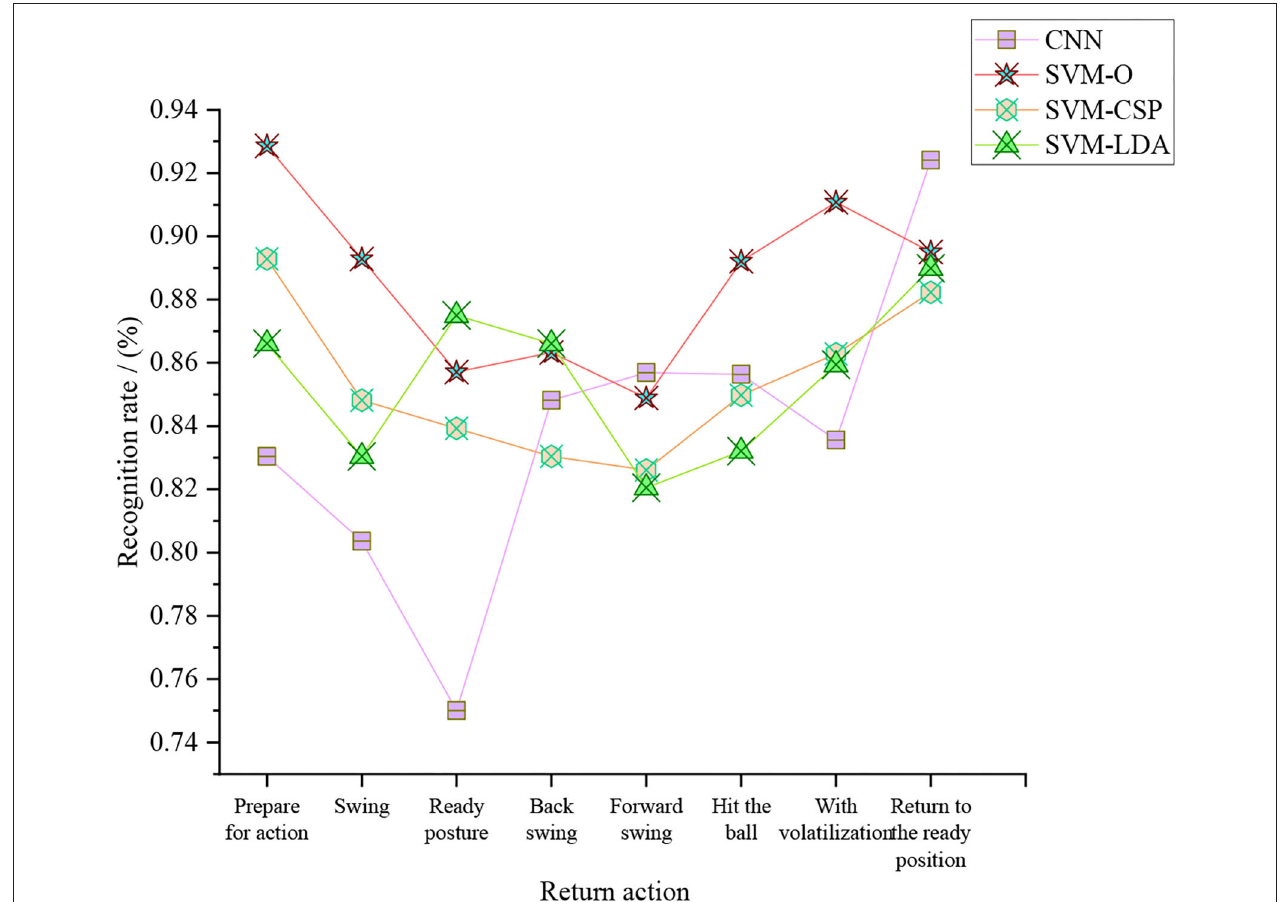
FIGURE 11 | Return recognition rate of the tennis sports robot under different